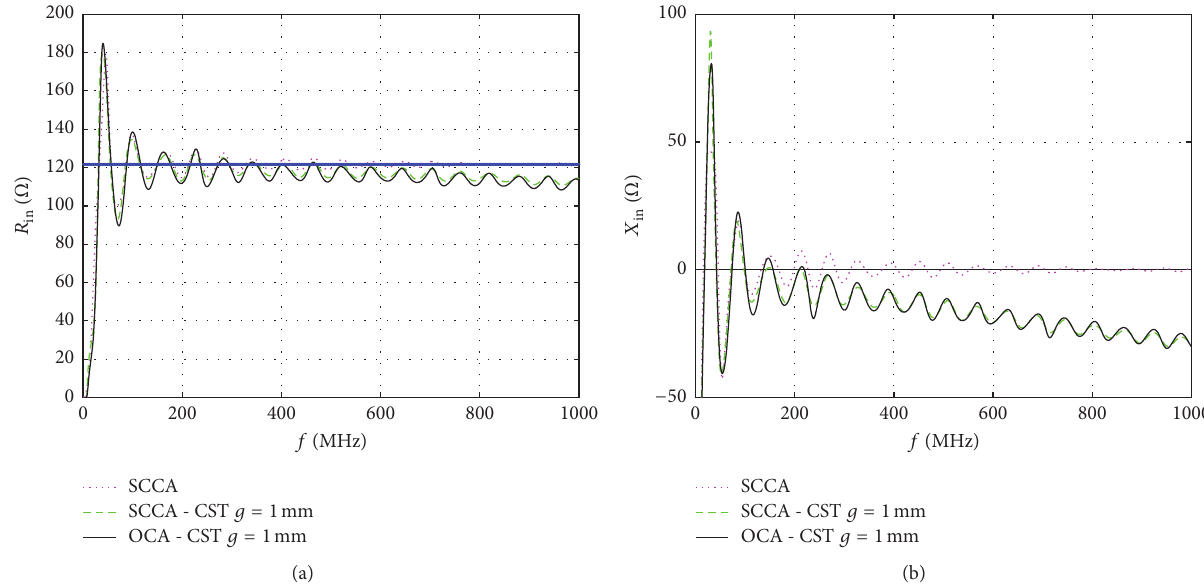
Figure 11: 𝑍 of the theoretical SCCA and the CST simulated SCCA and OCA for 𝜃 0 = 15 ∘ : (a) 𝑅 in